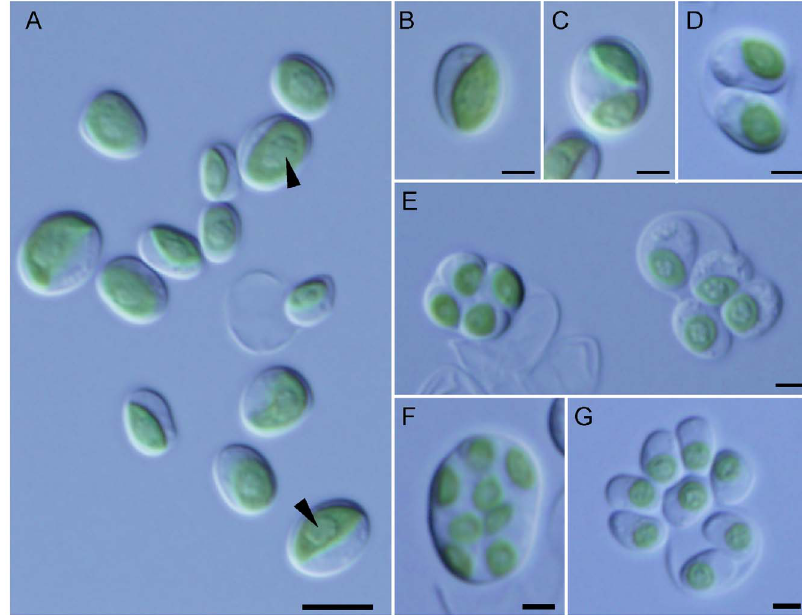
Figure 1. Cellular morphology of YKT1. Cells were observed by differential interference contrast microscopy. (A) Vegetative cells are single and ellipsoidal. Each cell typically has a single bright green parietal chloroplast with a pyrenoid (arrowhead) that occupies half of the cell periphery and there is no flagella. (B) A cell which contains a single chloroplast. (C) A cell which contains two divided chloroplasts. (D) Sporangium with two autospores. (E) Sporangium with four autospores. (F, G) Sporangium with eight autospores. Scale bars: 5 m m (A); 2 m m (B–G).